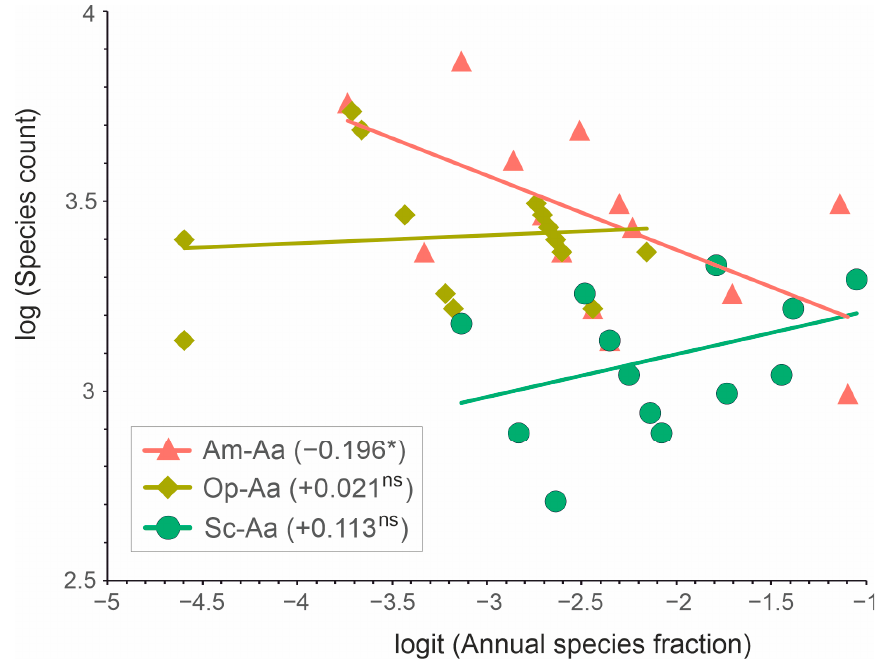
Figure 9. Spatially conditioned linear fit of (log-transformed) species richness against (logit- transformed) annual species fraction in each of the three Artemisia alba -(co)dominated communities distinguished in the Carpathian and Pontic regions. The numeric values between parentheses rep- resent the slopes of the fitted lines (0.01 < p * < 0.05; ns = non-significant). Abbreviations as in Figure